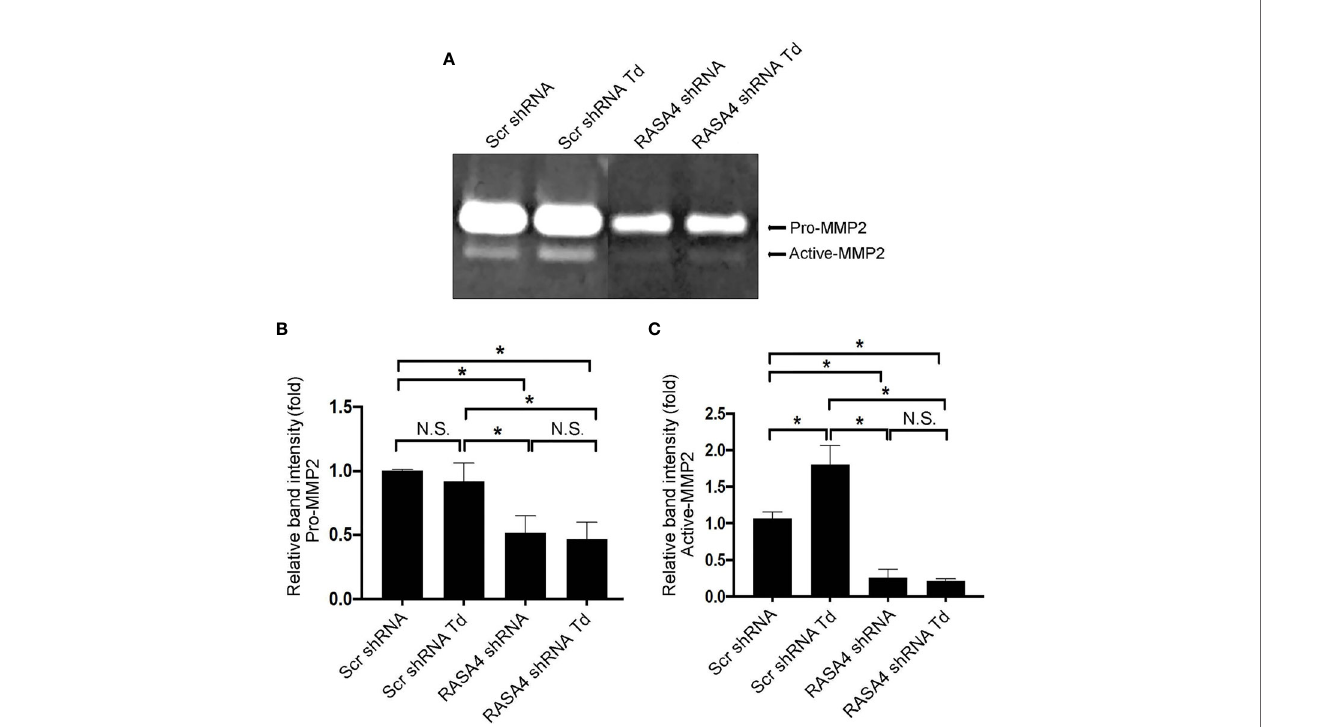
FIGURE 8 | RASA4 gene expression is required for T. denticola -mediated enhancement of MMP-2 activity. Pro-MMP-2 and active-MMP-2 in scramble shRNA and RASA4shRNA cells challenged with T. denticola (50 MOI) for 24 h. (A) a representative zymogram. (B) (Pro-Mmp-2) and (C) (active Mmp-2) show mean ± SD from three independent experiments. Data was compared using Two-way ANOVA Tukey ’ s Multiple comparisons test. * = p<0.05; N.S., not signi fi